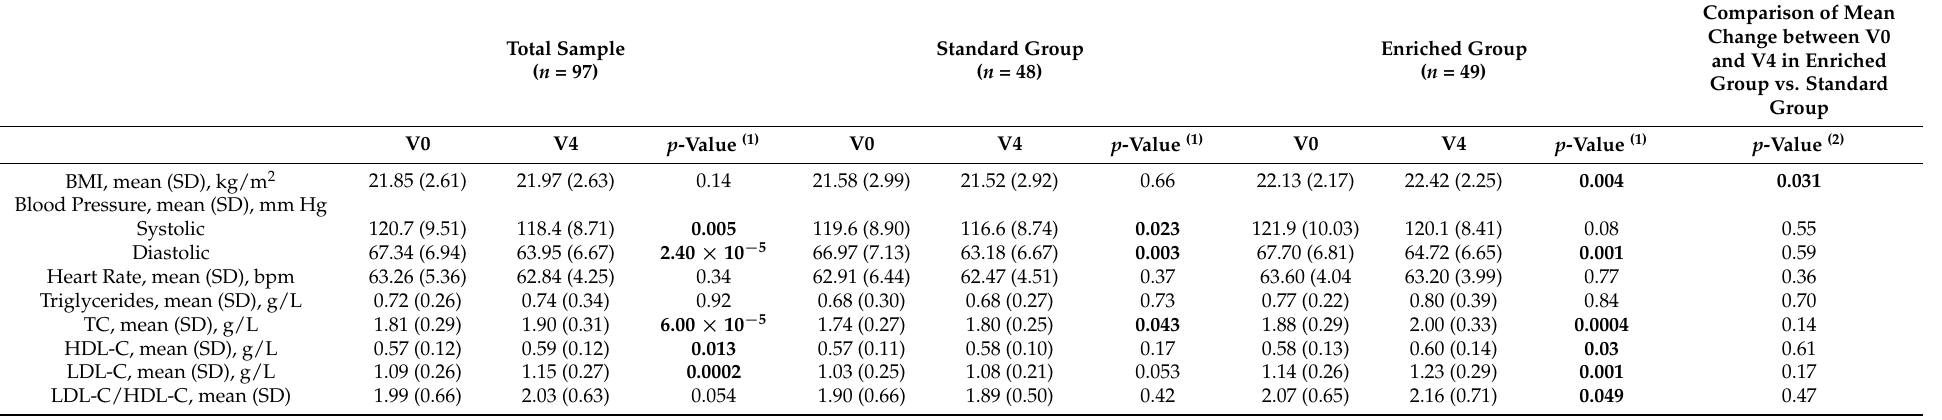
Table 3. Clinical parameters of participants before and after daily consumption of two standard or lutein-zeaxanthin-DHA-enriched eggs for 4 months.